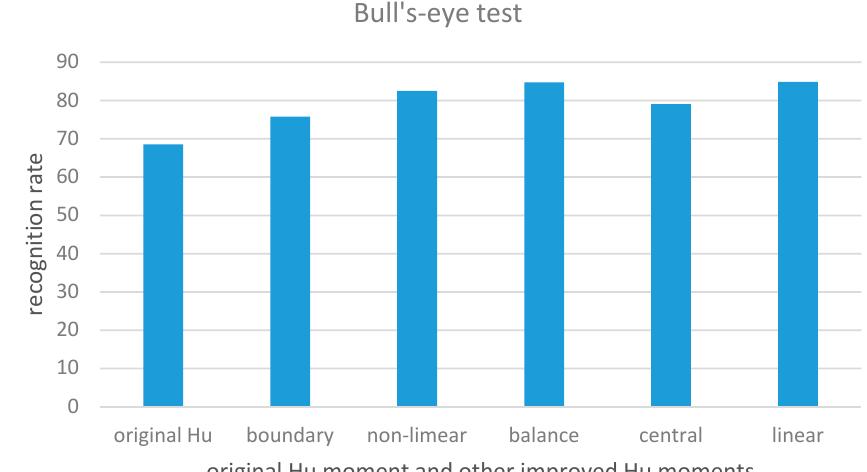
Figure 4. Bull’s-eye test on Kimia’s shape database.